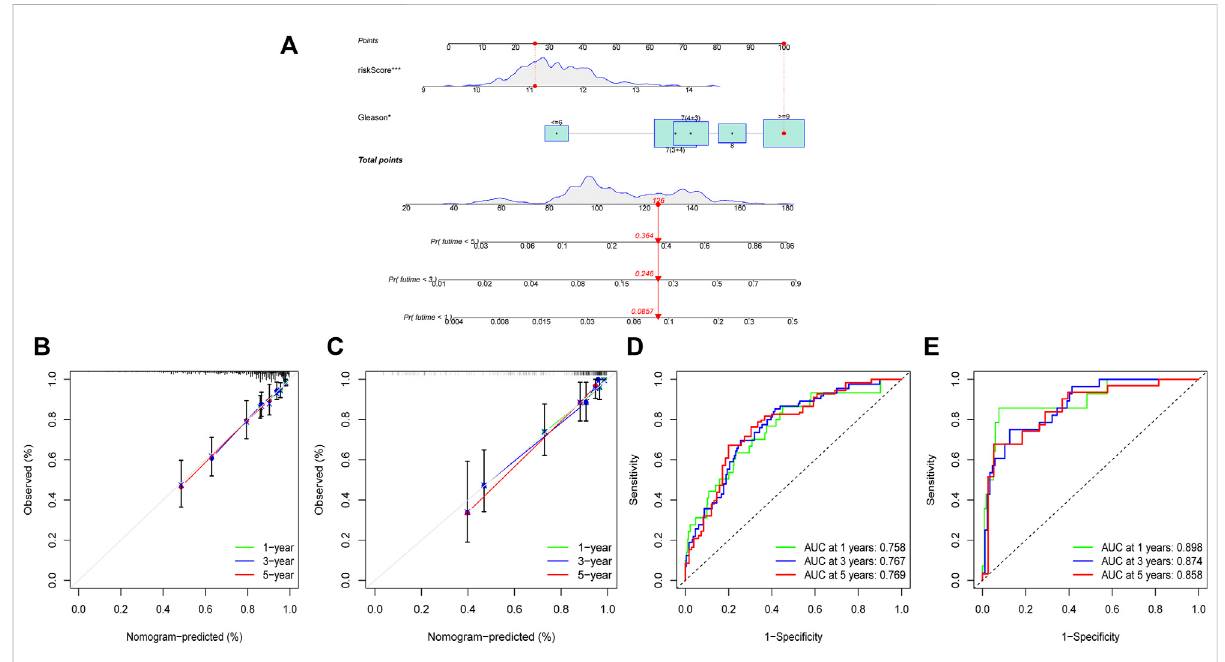
FIGURE 9 Construction and validation of a prognostic nomogram. (A) A nomogram established by the independent prognostic factors: risk score and Gleason. (B) The calibration curve of 1, 3, and 5-year in TCGA cohort. (C) The calibration curve of 1, 3, and 5-year in MSKCC cohort. (D) The ROC curve of 1, 3, 5-year in TCGA cohort. (E) The ROC curve of 1, 3, 5-year in MSKCC